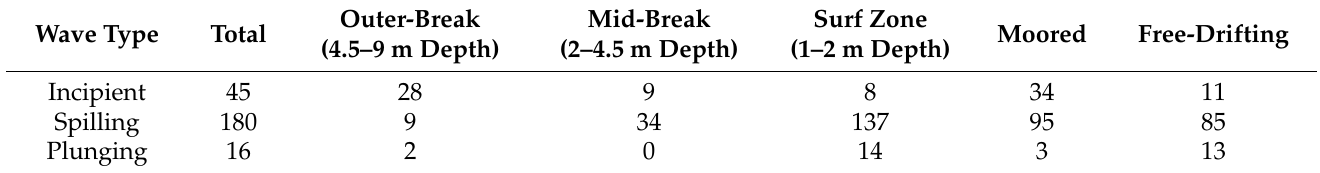
Table 1. Composition of the data for each wave type. This table provides the number of waves recorded in varying conditions. Wave Type Total